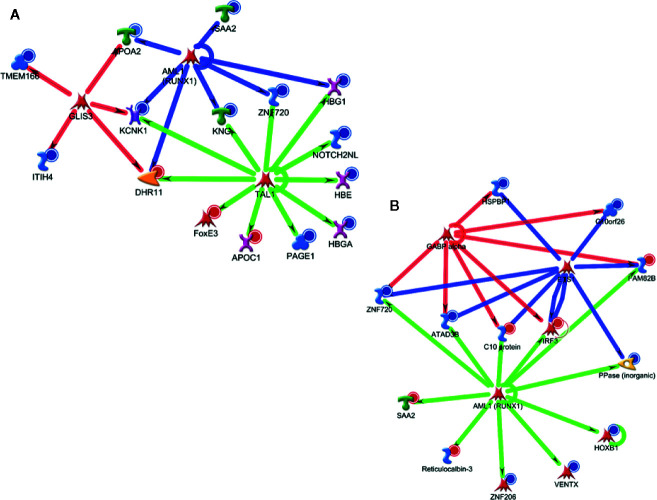
Major potential upstream regulators based on differentially expressed proteins at the blood in D0 (A) and D28 (B).